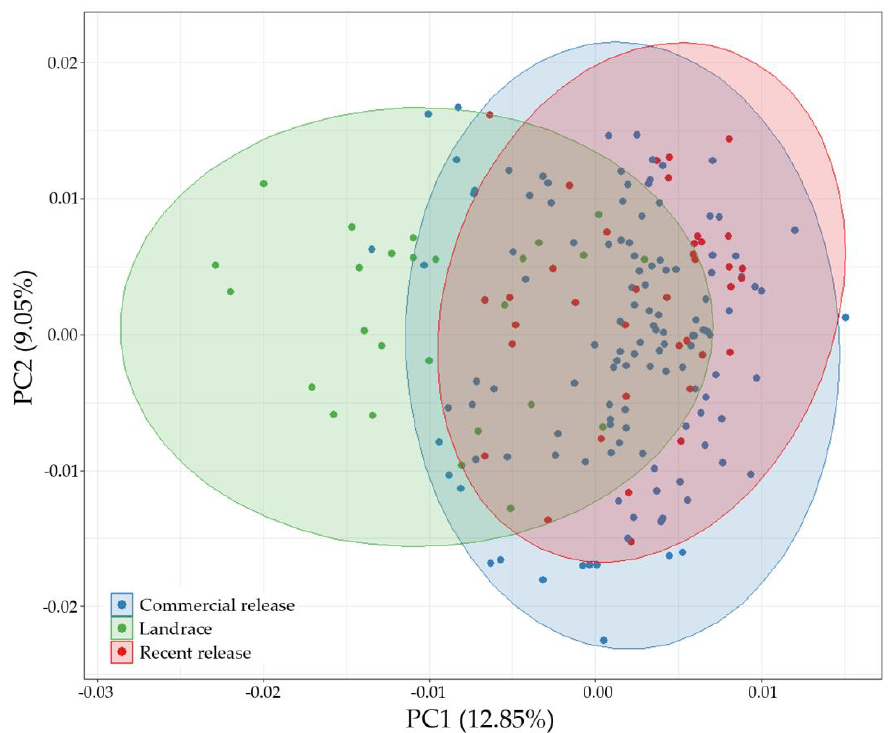
Figure 2. Principal Component Analysis based on ten microsatellite allele frequency data. Cultivars are color-coded by breeding origin: landraces (green), recent releases from breeding programs (red) and commercial releases from breeding programs (blue).